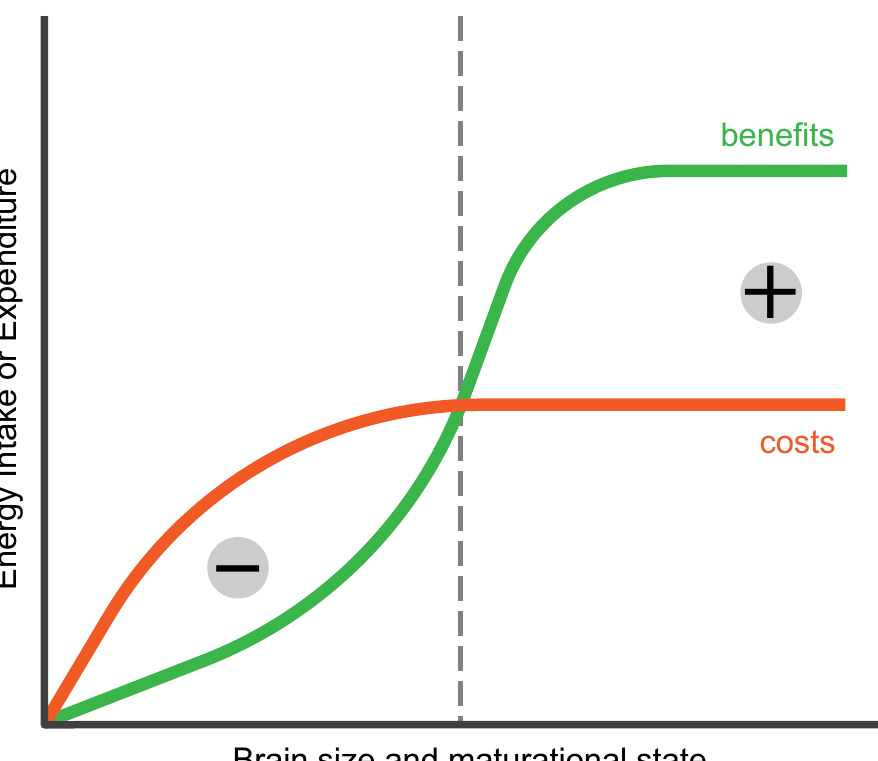
Fig 3. The bootstrapping problem for developing brains. In the absence of provisioning, immature animals developing their brains would likely face a long period of negative energy balance. Before the brain is fully grown and differentiated, it cannot provide adult-level cognitive benefits and the concomitant energy intake (green curve). The costs of growing, differentiating, and maintaining the brain (red curve) rise early and may even exceed adult values due to higher relative brain size of older immatures in mammals and costs of brain differentiation, before cognitive benefits, with their corresponding net energetic intake, stabilize at adult level. As a result, without parental provisioning the individual’s energy balance would be positive only after adulthood was